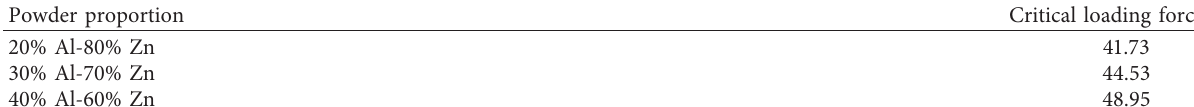
Table 2: Critical loading force of three coatings.